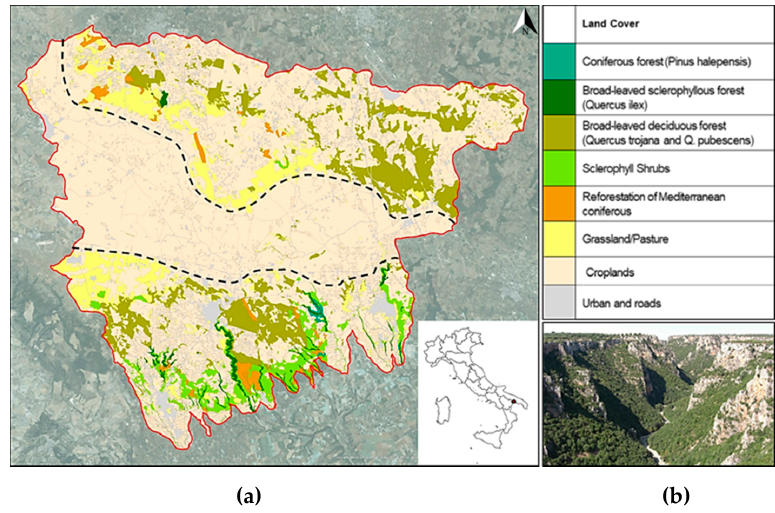
Figure 1. The study area localized in Southern Italy: ( a ) division of the area into three longitudinal strips. The red line indicates the edge of the study area; ( b ) Gravina of Laterza (Taranto, Southern Italy). The northern zone, between 500 and 380 asl, is characterized by hills generally with south- and south-east exposure, where there are forests of Quercus trojana Webb. The central area, between 400 and 220 asl, consists of a slightly wavy plain, used almost everywhere for agricultural crops [33]. The southern zone, between 350 and 160 asl, is morphologically more complex owing to the presence of a series of deep incisions that appear similar to North American canyons [34], termed ‘gravine’ (Figure 1b). The vegetation mainly comprises forest communities characterized by an accentuated physiognomic and compositional heterogeneity [33]. The transects reported in Figure 2 show the inhomogeneity of the study area and the different degrees of morphological complexity of the three zones reported in Figure 1.